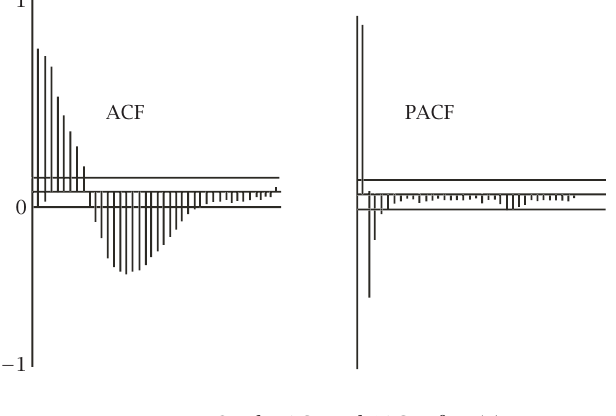
Figure 5.2 . The ACF and PACF of X